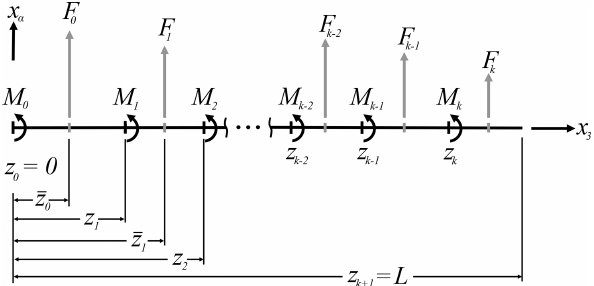
Figure 4. Free body diagram used to determine transverse loads from a given distribution of moments along the blade